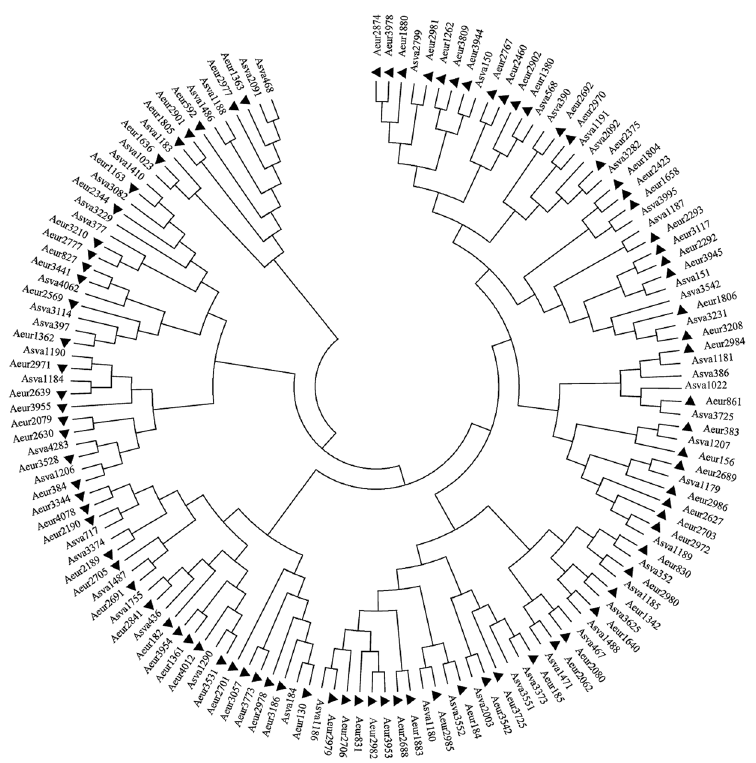
Figure 5. Phylogenetic relationships of genes related to monosaccharide